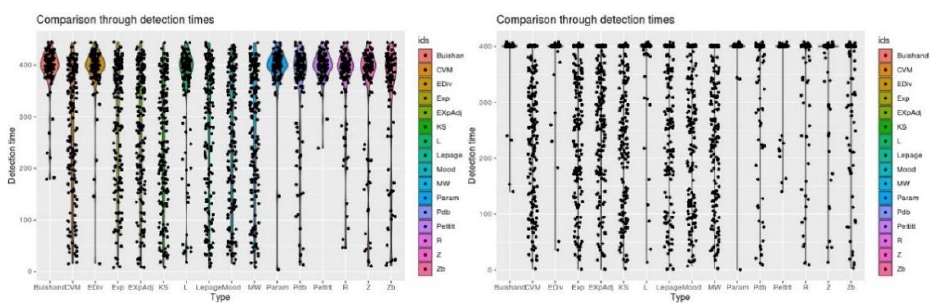
Fig. 3. Change identification under stationarity: left panel - failure truncation, right panel - time